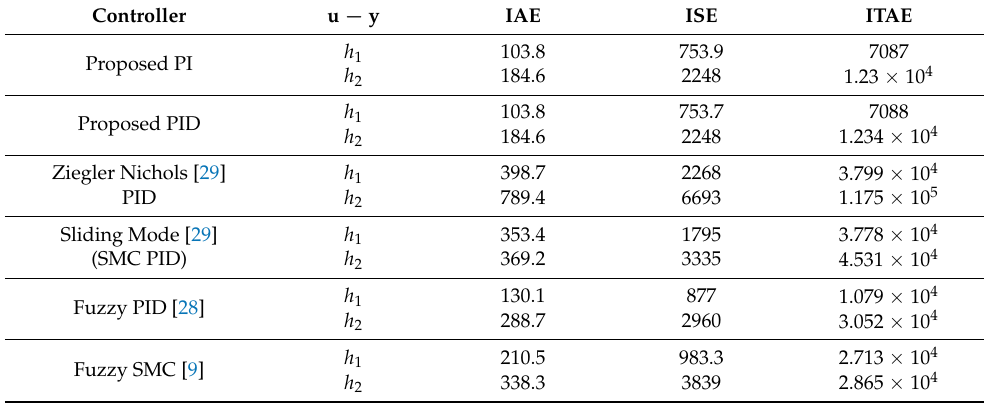
Figure 15. Regulatory response. ( a ) Level Variation in tank 1. ( b ) Control output. ( c ) Level Variation in tank 2. ( d ) Control output. Table 2. Performance indices: coupled spherical